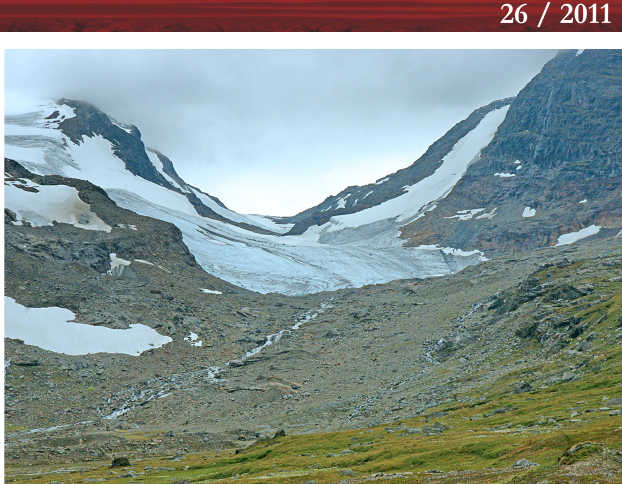
Figure 11: The lower front of Östra Syterglaciären (7). Upslope parts are disguised in clouds. 2010-08-21.